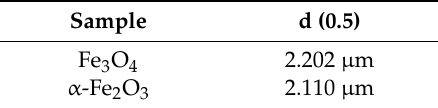
Table 2. Value of particle size.